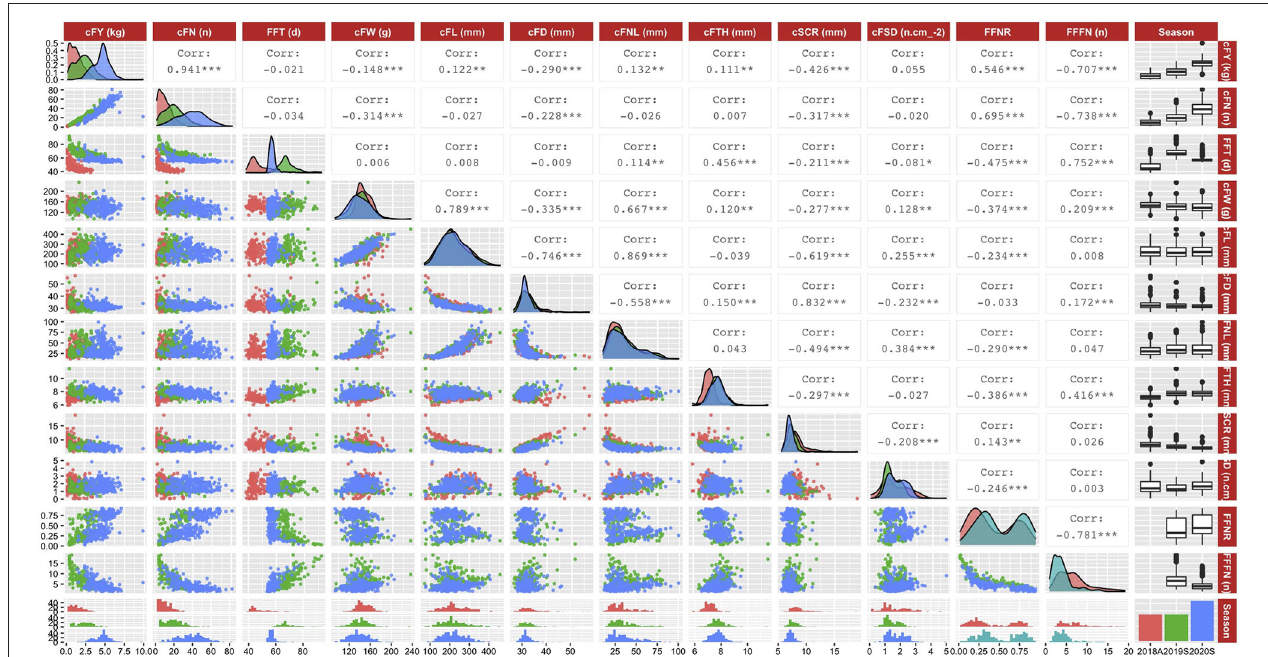
FIGURE 3 | Distribution and correlation relationship among best linear unbiased estimates of traits in three seasons. A total of 12 traits information in three seasons is visualized. The upper right part is the Pearson’s correlation coefficient among traits (***: p < 0.001; **: p < 0.01; and *: p < 0.05); the diagonal position is the density distribution of traits in three seasons; and the lower left part is the scatter plot among traits in different seasons. Red color, traits in autumn 2018; green color, traits in spring 2019; blue color, traits in spring